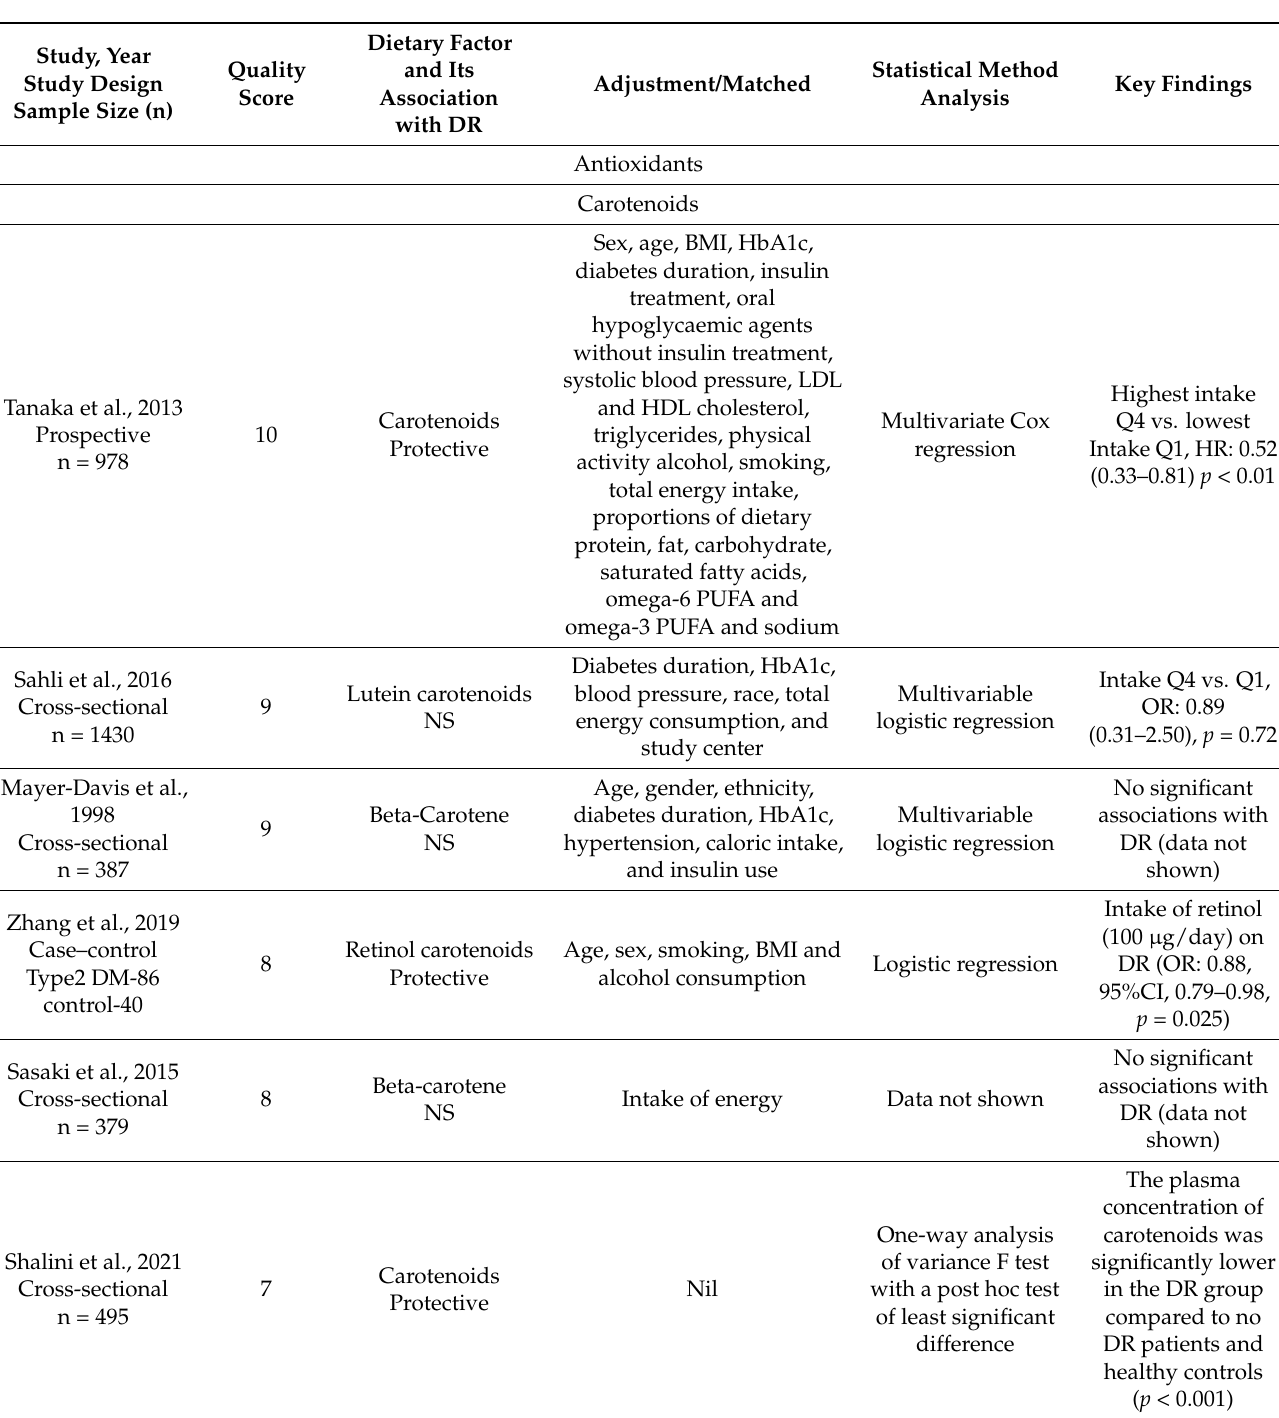
Table 2. Dietary intake of micronutrients and diabetic